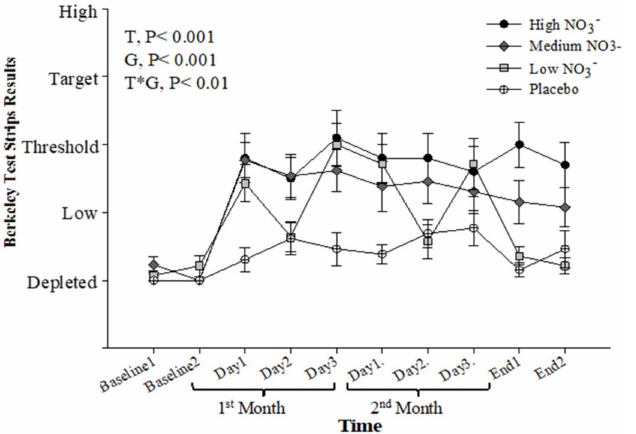
Figure 9. Salivary NO 2 − strips readings (Berkeley). Mean salivary NO 2 − strips readings (Berkeley) measured at baseline, 4 weeks, 8 weeks, and after 13 weeks. HN (High NO 3 − ; two 70mL shots of BJ/day, morning and evening), MN (Medium NO 3 − ; 70 mL of BJ/day), LN (Low NO 3 − ; 70 mL of BJ every alternate days) and PL (placebo; 70 mL of NO 3 − depleted BJ). Each shot of BJ contains 400 mg of NO 3 − . Data were analysed using a 2-factor repeated measures ANOVA (time*group of intervention). Data are expressed as mean ± SEM, ( n =